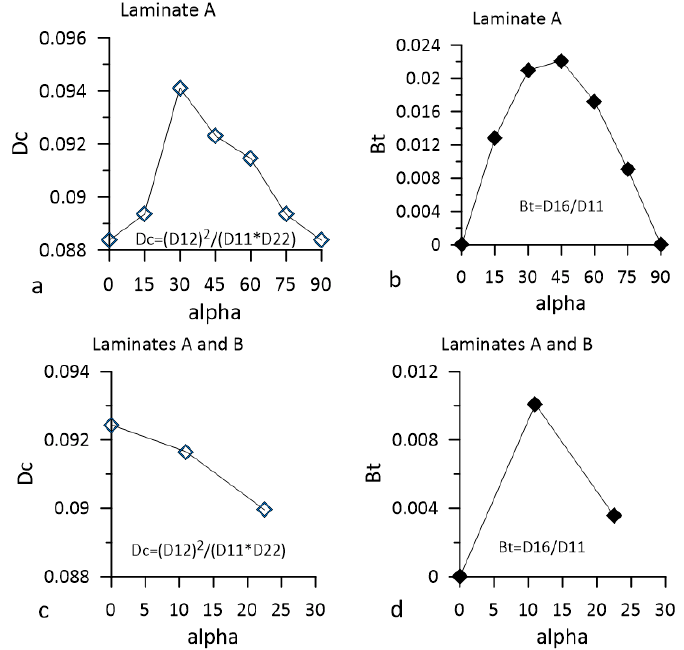
Figure 5. Dc and Bt coefficient calculated for the used hybrid beam specimens. ( a , b ) The lower branches of the specimen representing Laminate A; ( c , d ) upper branches of the specimens representing Laminates A and B.